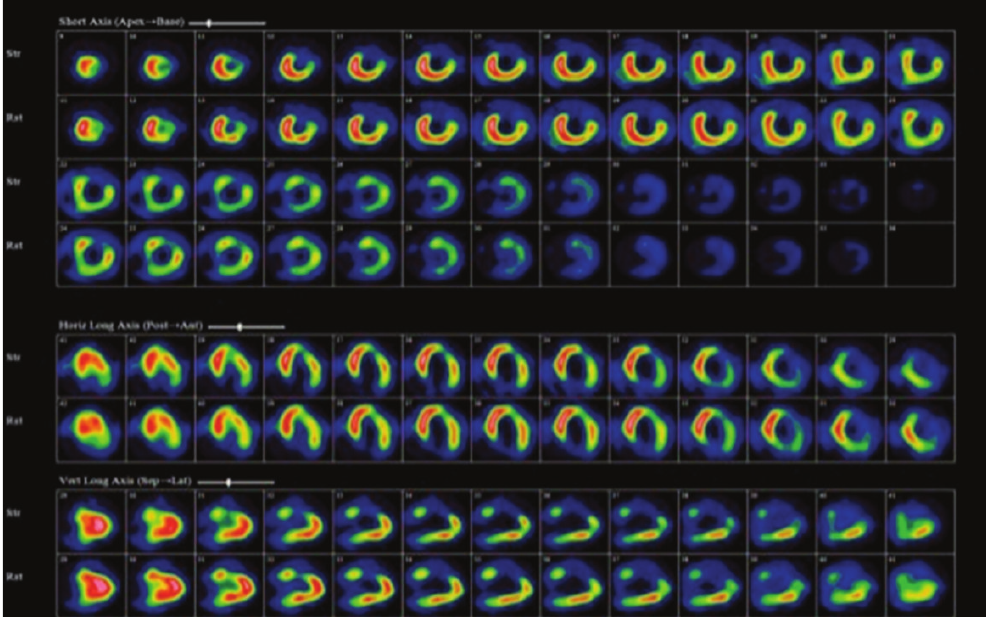
Figure 1: Baseline Tc-99m SPECT myocardial perfusions scan from CRT candidate demonstrating a fixed perfusion defect involving anterior and anterolateral wall consistent with transmural scar. Intraoperative testing demonstrated a high pacing threshold at anterolateral LV lead position; excellent pacing threshold was obtained from a posterolateral coronary sinus branch.